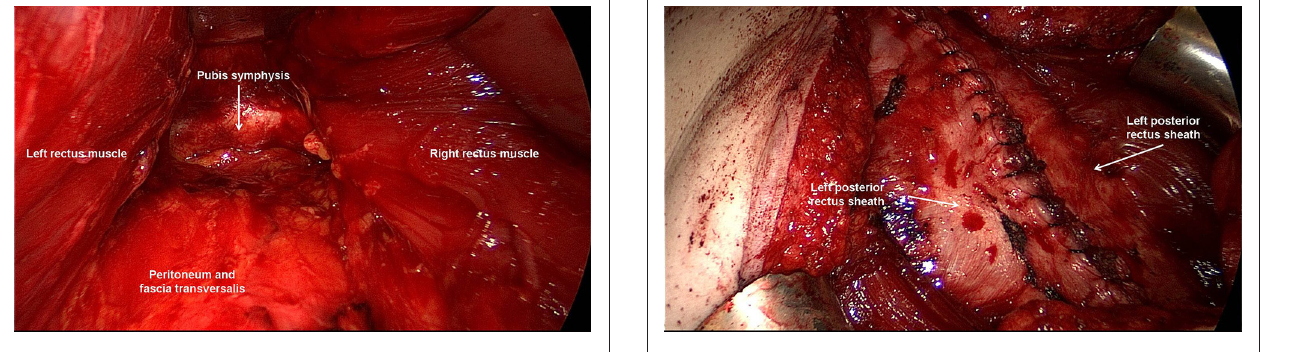
FIGURE 7 | Inferiorly, the space of Retzius is entered to expose the pubis symphysis. Below the arcuate line, the posterior layer only includes peritoneum and transversalis fascia.